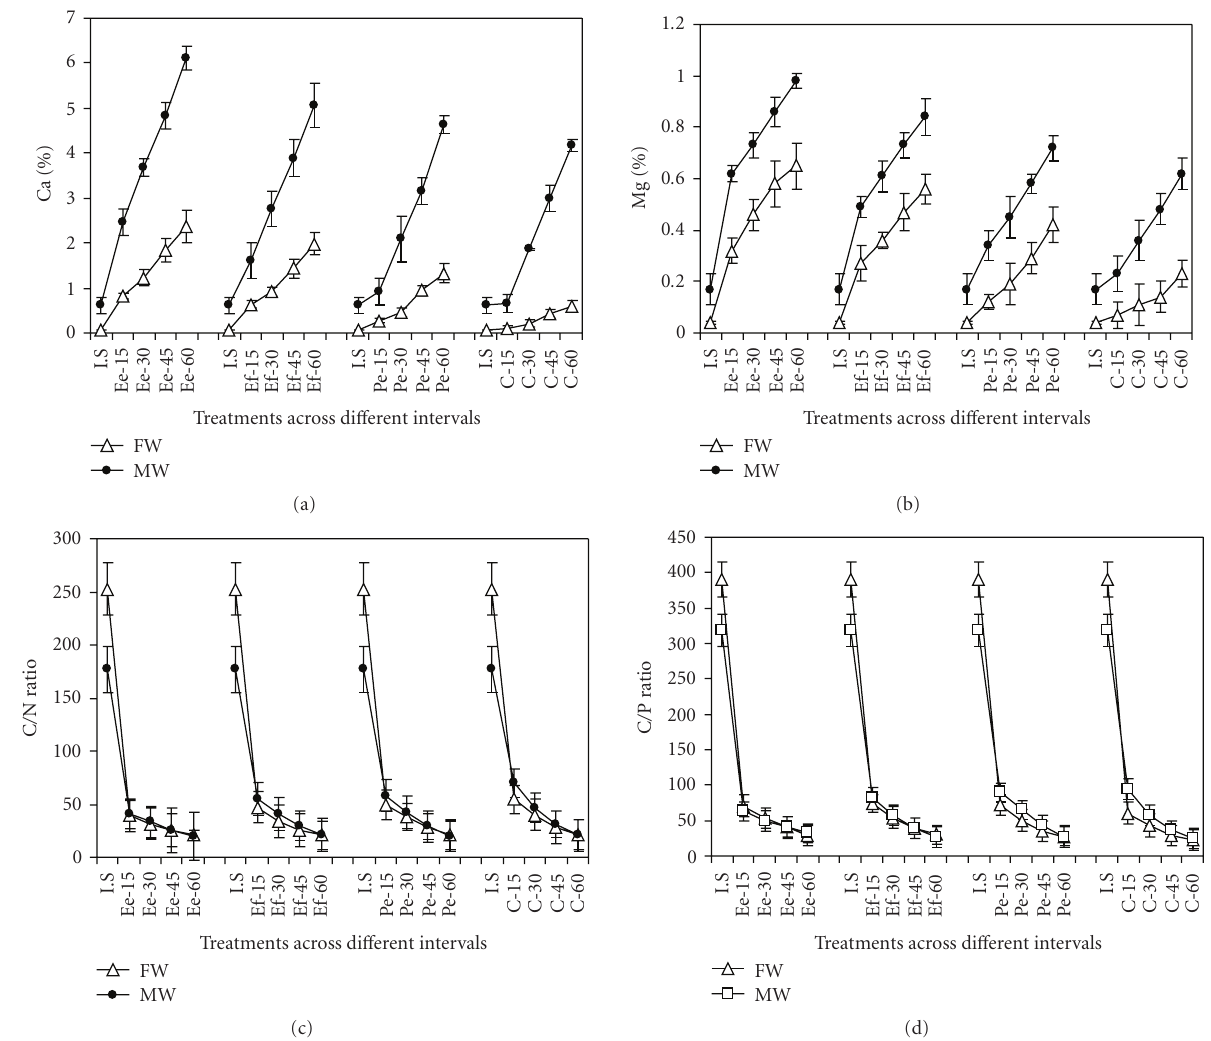
Figure 2: Major nutrients—Ca and Mg (%), C/N ratio and C/P ratio of vermicompost (VC) of three di ff erent species of earthworms— Eudrilus eugeniae (Ee) at 15 days (Ee-15), 30 days (Ee-30), 45 days (Ee-45), and 60 days (Ee-60); Eisenia fetida (Ef) at 15 days (Ef-15), 30 days (Ef-30), 45 days (Ef-45), and 60 days (Ef-60); Perionyx excavatus (Pe) at 15 days (Pe-15), 30 days (Pe-30), 45 days (Pe-45), and 60 days (Pe-60); and Compost (C) at 15 days (C-15), 30 days (C-30), 45 days (C-45), and 60 days (C-60) produced from FW and MW. (a) Ca, (b) Mg, (c) C/N ratio, (d) C/P